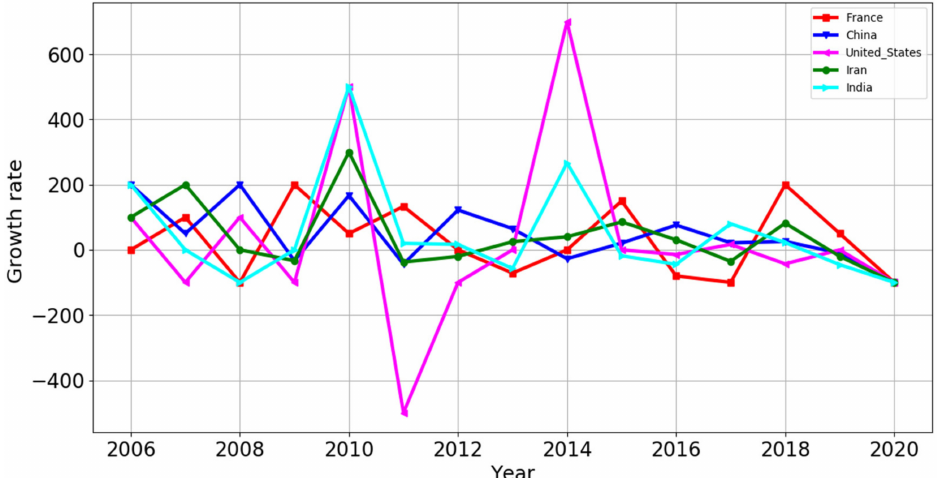
Figure 17. Growth rate of published documents for top 5